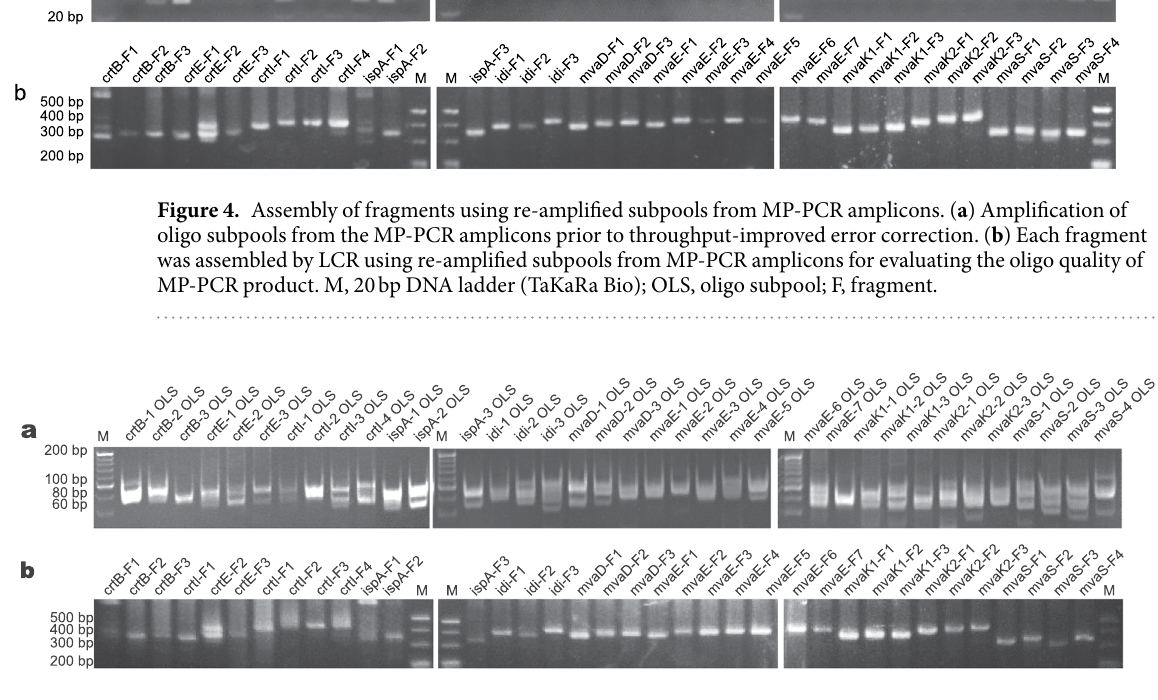
Figure 5. Assembly of fragments using oligos after entire pool annealing and error-removal by MICC. ( a ) Amplification of oligo subpools from the MP-PCR amplicons after throughput-improved error correction. ( b ) Each fragment was assembled by LCR from error-depleted oligo subpools. M, 20 bp DNA ladder (TaKaRa Bio); OLS, oligo subpool; F,